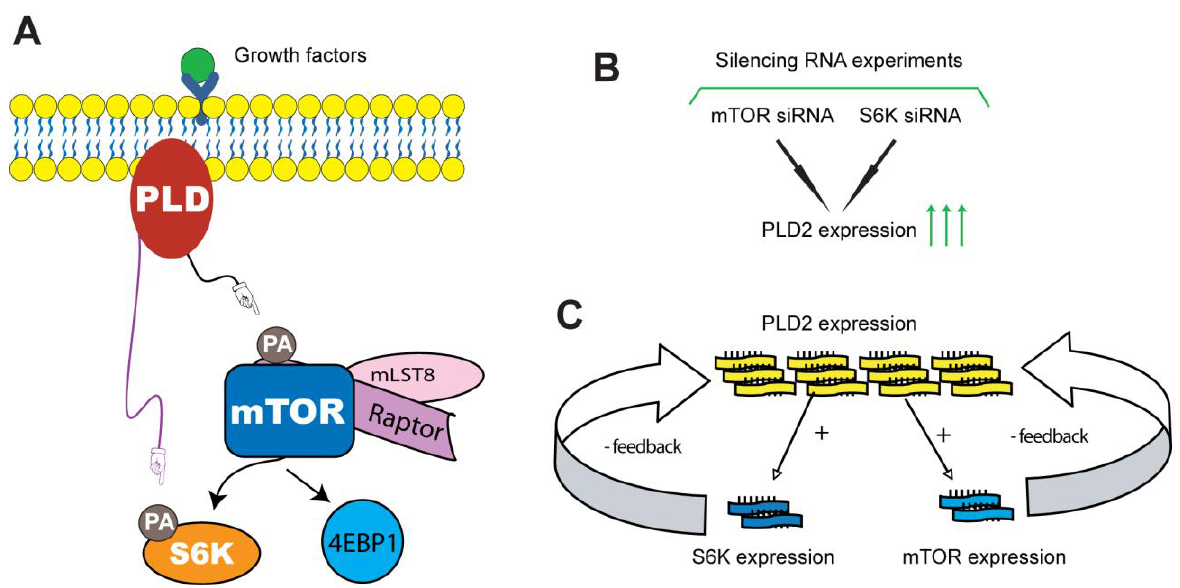
FIGURE 4. Introducing the concept of mTOR/S6K upstream signaling and involvement on PLD2 gene expression. (A) This panel shows that PLD produces PA, which directly binds to mTOR and also to S6K. mTOR (complex-1, associated to Raptor) activates S6K and that is the onset of protein translation in the cell and other functions. (B) Silencing experiments indicate that when S6K or mTOR are silenced, PLD2 gene expression is elevated. (C) Model showing that mTOR and S6K negatively regulate PLD2 expression. This can be rescued by cell stimulation with chemoattractants (such as IL-8 in